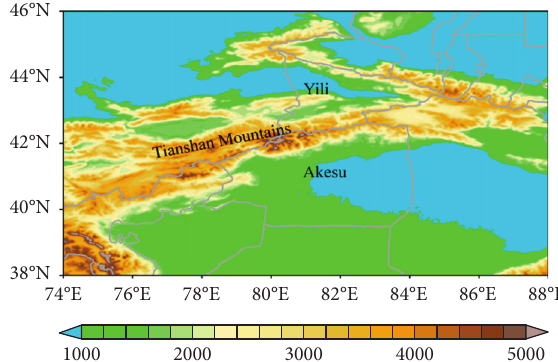
Figure 1: Study area (the shadow is the height of the terrain, unit: